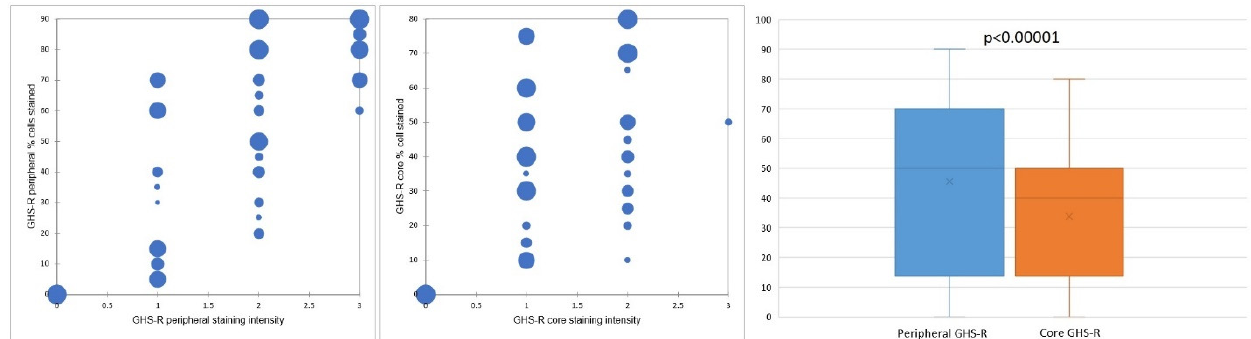
Figure 2. GHS-R staining distribution and preferential staining pattern in tumor periphery vs. tumor core.